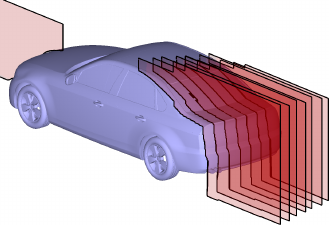
Figure 10. Illustration of PIV planes